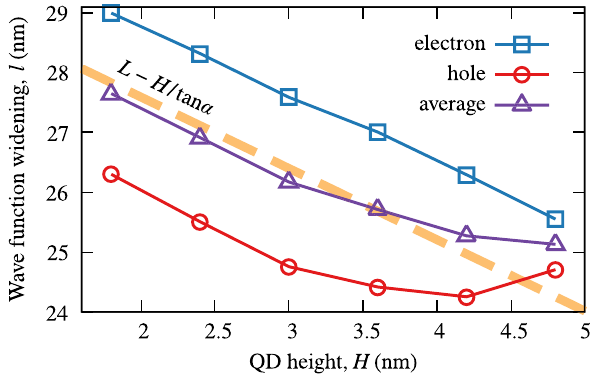
Figure 8. Effective QD in-plane size. In-plane extension of electron (full symbols) and hole (empty symbols) ground-state wave functions versus QD height. Solid lines are to guide the eye, while dashed line shows analytical